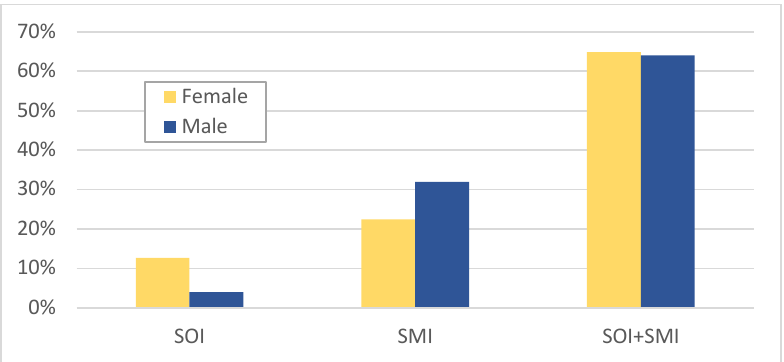
Figure 2. Distribution of SOI (sleep onset insomnia), SMI (sleep maintenance insomnia) and SOI + SMI (combined sleep onset insomnia and sleep maintenance insomnia) between genders.